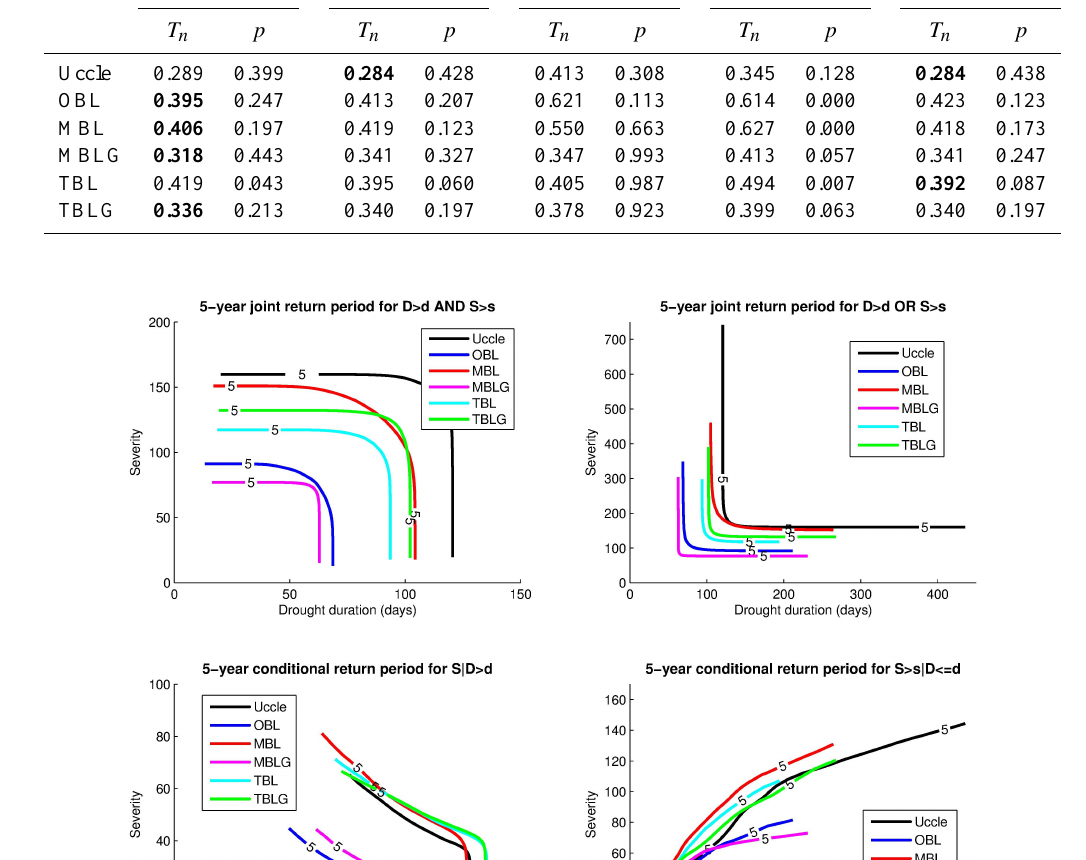
Table 11. T n and p values for D and S for different copulas. The best fit is indicated in bold. Data